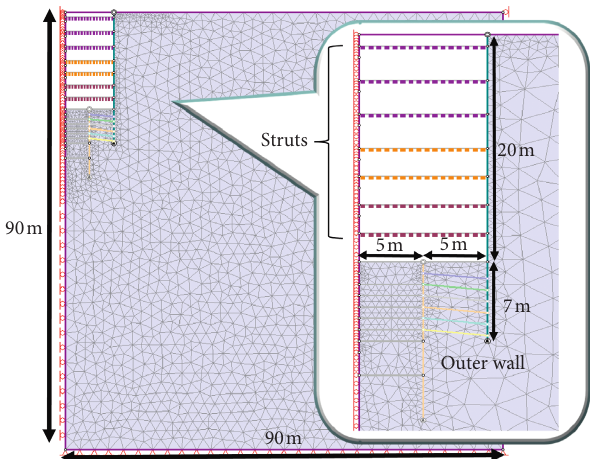
Figure 3: Analysis step constructing the outer wall and installing the 7 struts.